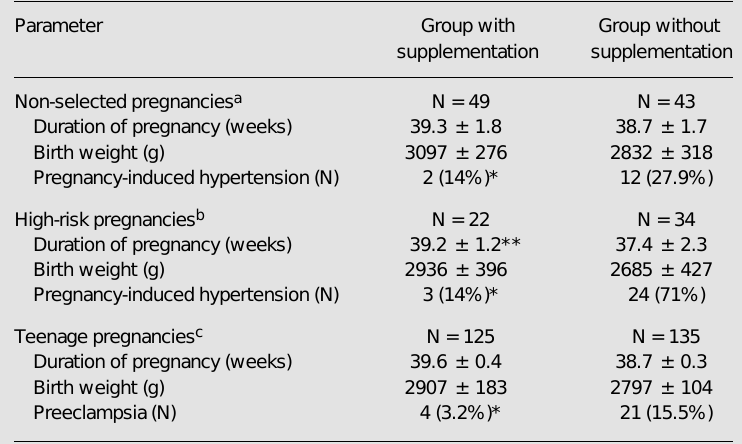
Table 1. Effect of calcium supplementation on the outcomes of Ecuadorian pregnant women. Parameter Group with Group without supplementation supplementation